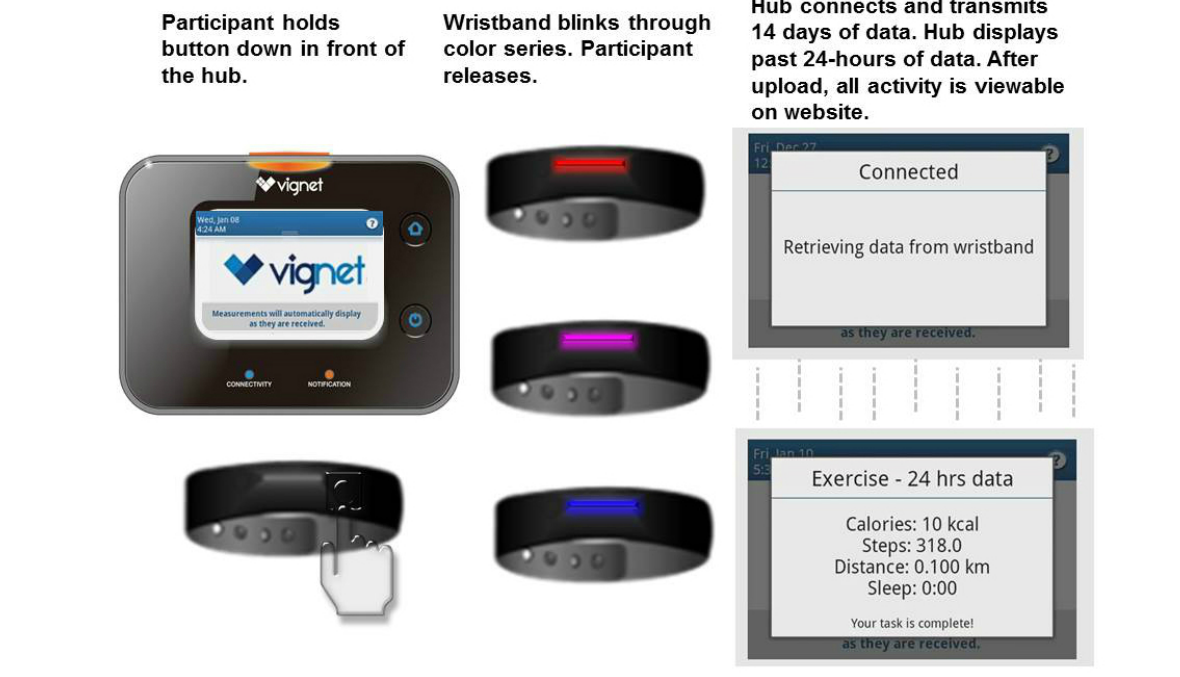
Figure 4. Physical activity-monitoring wristband with hub; Cardiovascular Health and Needs Assessment Qualitative Study,